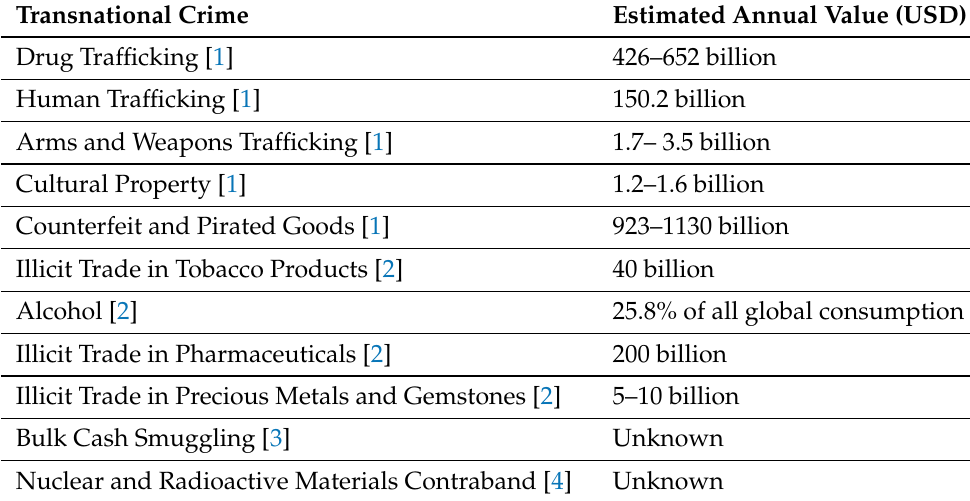
Table 1. The retail value of transnational crime (in